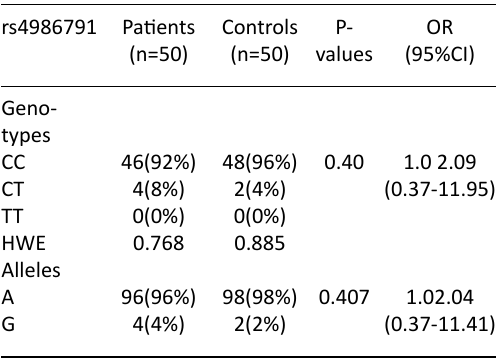
Fig. 2. Chromatograph of DNA sequencing for TLR-4 rs4986790 A/G polymorphism. Upper: wild-type homozygous genotype (AA), lower: heterozygous genotype (AG). Table 3. Genotypes and alleles of TLR-4 rs4986790 in patients with IgM seropositive anti- toxoplasma Abs and controls